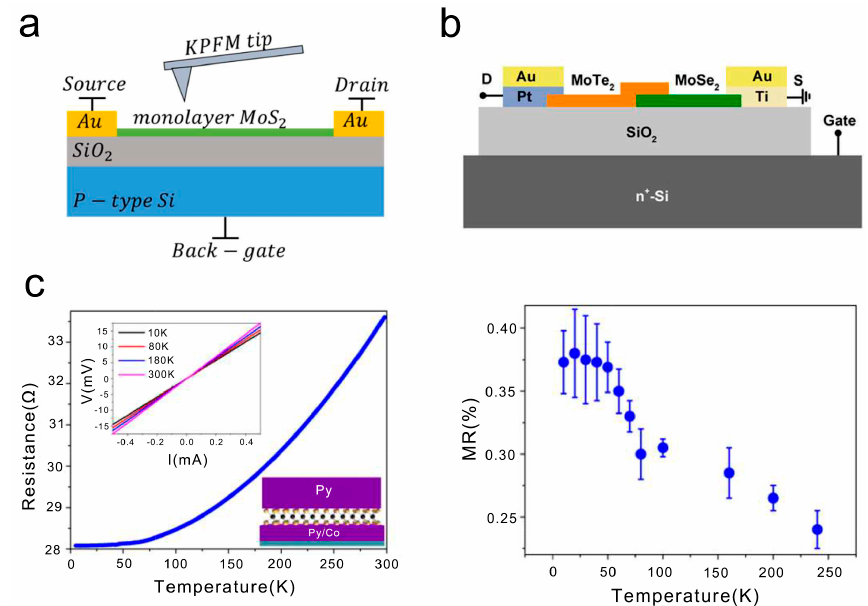
Figure 6. Application of TMDs phase structure electronics. ( a ) MoS 2 -based FET, schematics of a field-effect transistor (FET) composed of a monolayer molybdenum disulfide (MoS 2 ) layer as the channel, drain, and source gold terminals, and a back-gate, in addition to the Kelvin probe force microscopy (KPFM) tip. Reproduced from [84], with the permission of the MDPI. ( b ) Schematic of the MoTe 2 /MoSe 2 heterojunction device. During electrical measurements, the source terminal (S) is grounded while the bias is applied to the drain terminal (D) or Si gate. Reproduced from [87], with the permission of the MDPI. ( c ) Temperature dependence of junction resistance and magnetoresistance (MR) curves at different temperatures of NiFe/MoS 2 /NiFe/Co. Reproduced from [88], with the permission of the American Chemical Society.